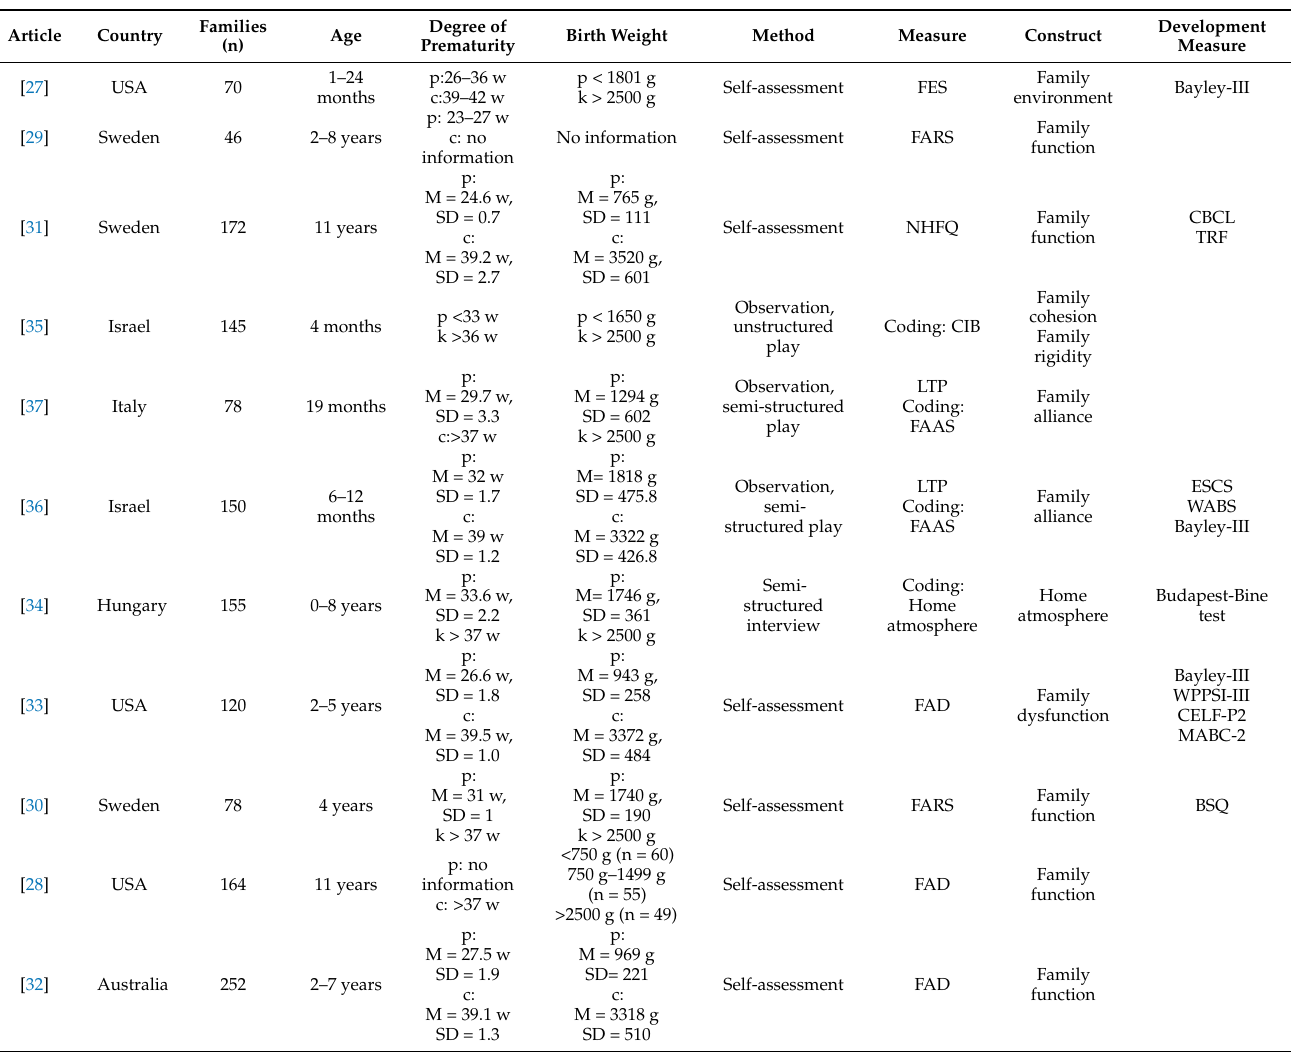
Table 2. Included